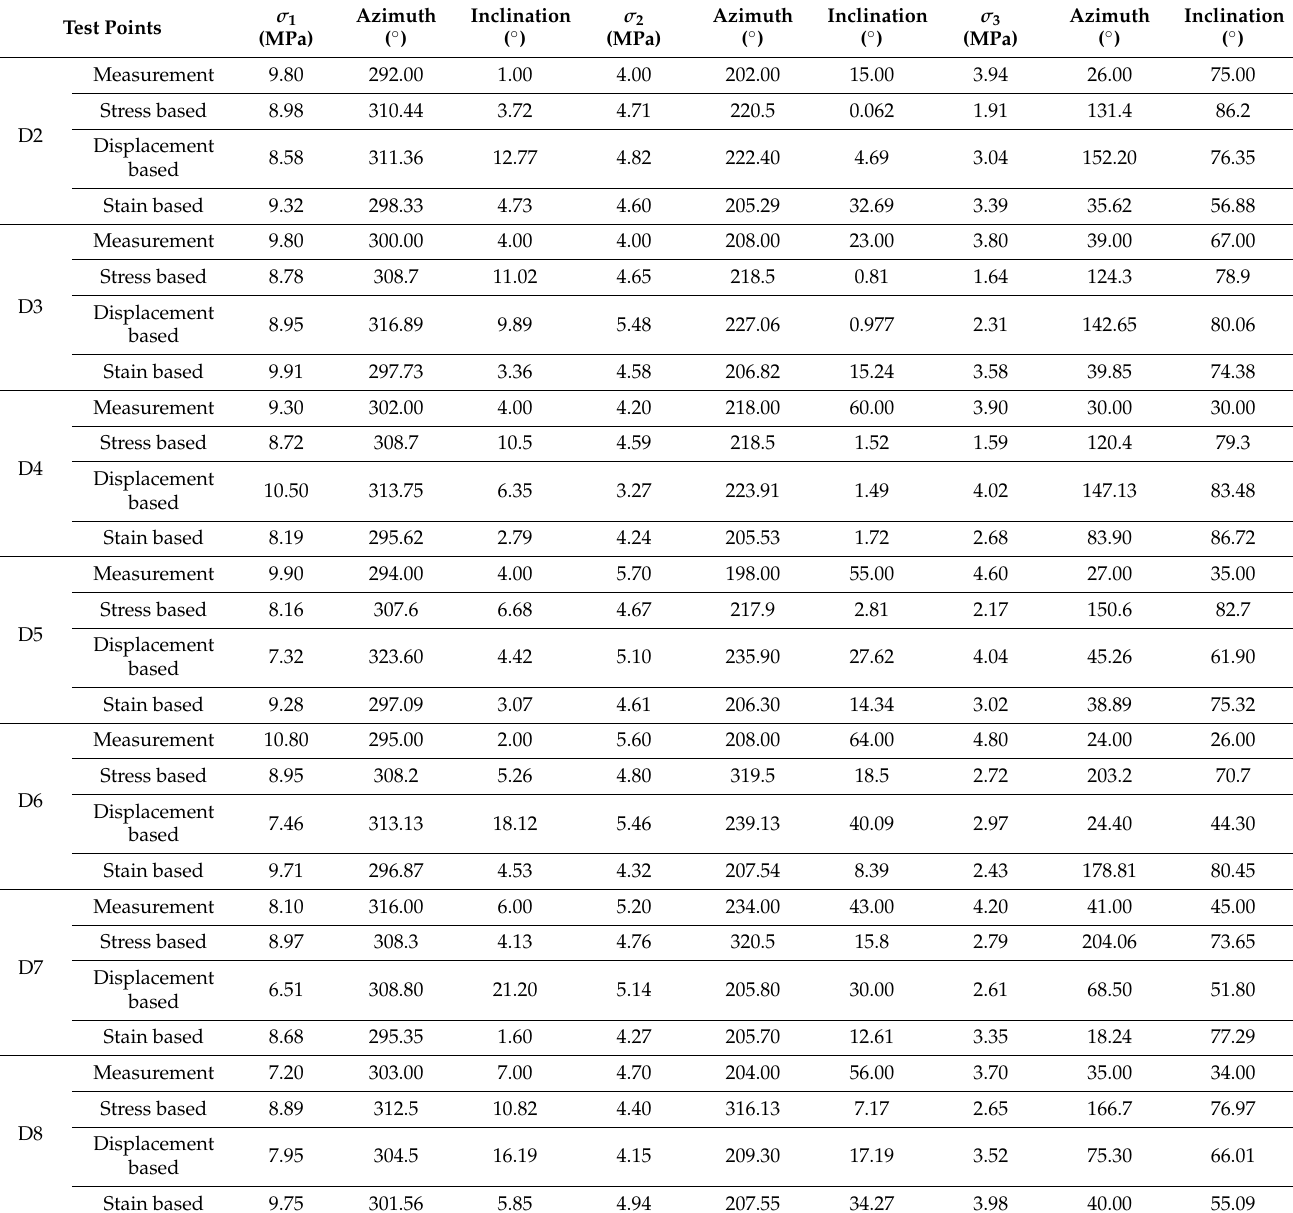
Table 3. Contrast data of principal stress under geodetic coordinate system.